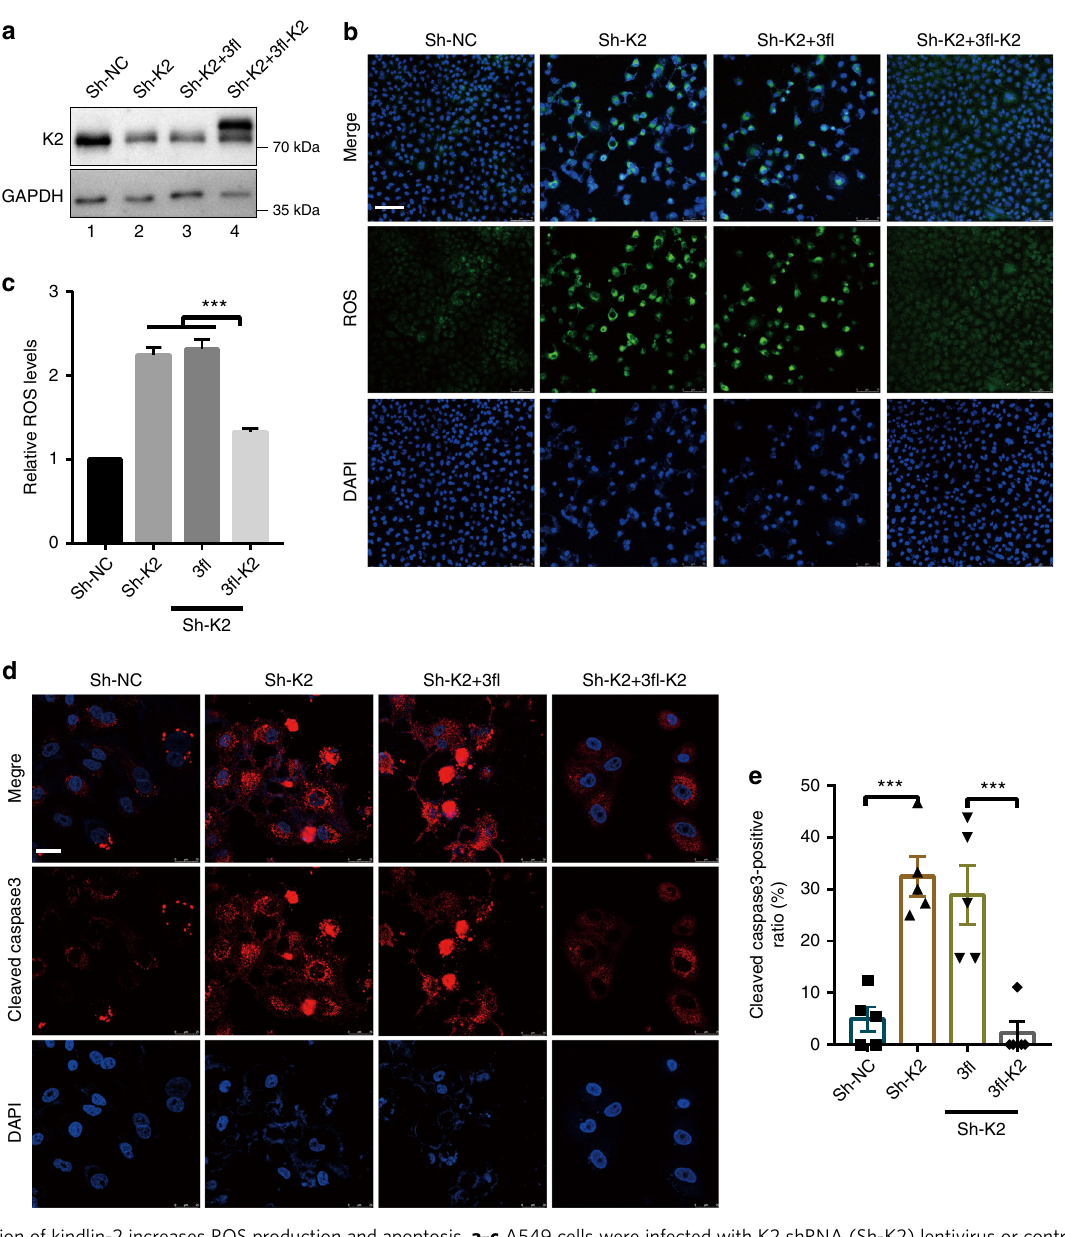
Fig. 5 Depletion of kindlin-2 increases ROS production and apoptosis. a – c A549 cells were infected with K2 shRNA (Sh-K2) lentivirus or control lentivirus (Sh-NC). Two days after the infection, the cells were infected with lentiviral expression vectors encoding 3xFLAG-tagged kindlin-2 (3 fl -K2) or 3xFLAG empty vector (3 fl ). Three days after the lentiviral infection, the cells were analyzed by western blotting with antibodies recognizing K2 or GAPDH (as a loading control) ( a ). The levels of ROS were analyzed using DHE fl uorescence probe as described in the Methods ( b ). Scale bar, 75 μ m. The mean fl uorescence intensities (MFI) were calculated using the Image-pro plus software from two different experiments ( c , at least n = 15 fi eld per group were counted from at least three independent experiments). d The cells (as speci fi ed in the fi gure) were immuno fl uorescently stained with DAPI and anti- cleaved caspase-3 antibody. Scale bar = 25 μ m. The percentages of cleaved caspase-3-positive cells were quanti fi ed ( e ) as described in the Methods. Replicates ( n = 5) from one representative experiment are shown. Data in c and e are presented as mean ± SEM using one-way ANOVA with Tukey – Kramer post-hoc analysis, * P < 0.05; *** p <